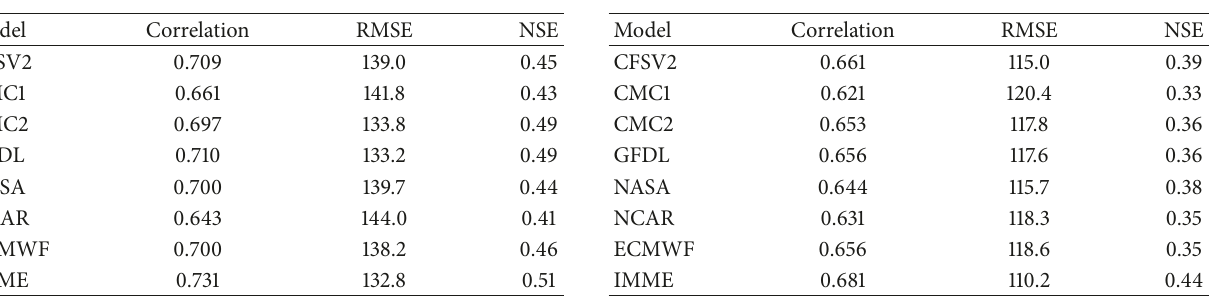
Table 5: Correlation, RMSE, and NSE for observed three months’ precipitation versus the models predictions: Central Israel,